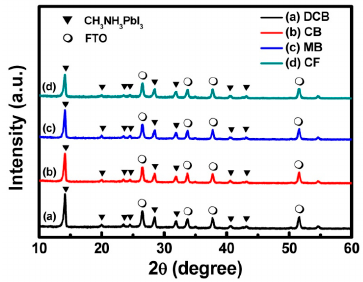
Figure 6. The X-ray diffractometer (XRD) results for PCBM ETLs based on various